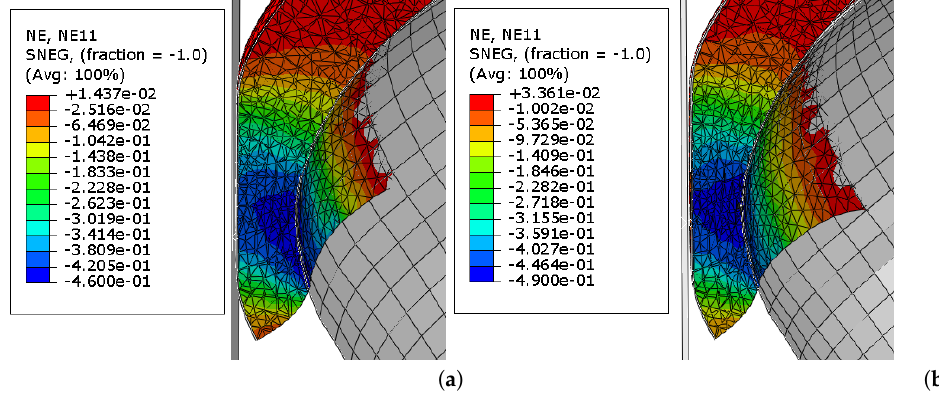
Figure 10. Maximum deformation of a liner with a thickness of 40 mm: ( a ) First impact. ( b ) Second